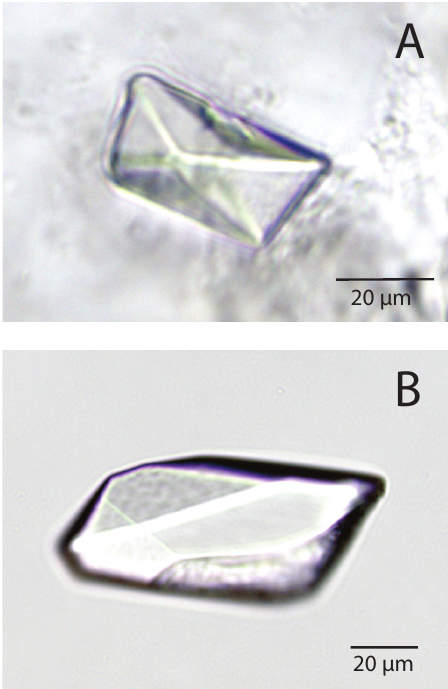
Fig. 7. Two most common forms of ikaite in freezing sea ice. (A) rhombs, (B) thin plates.